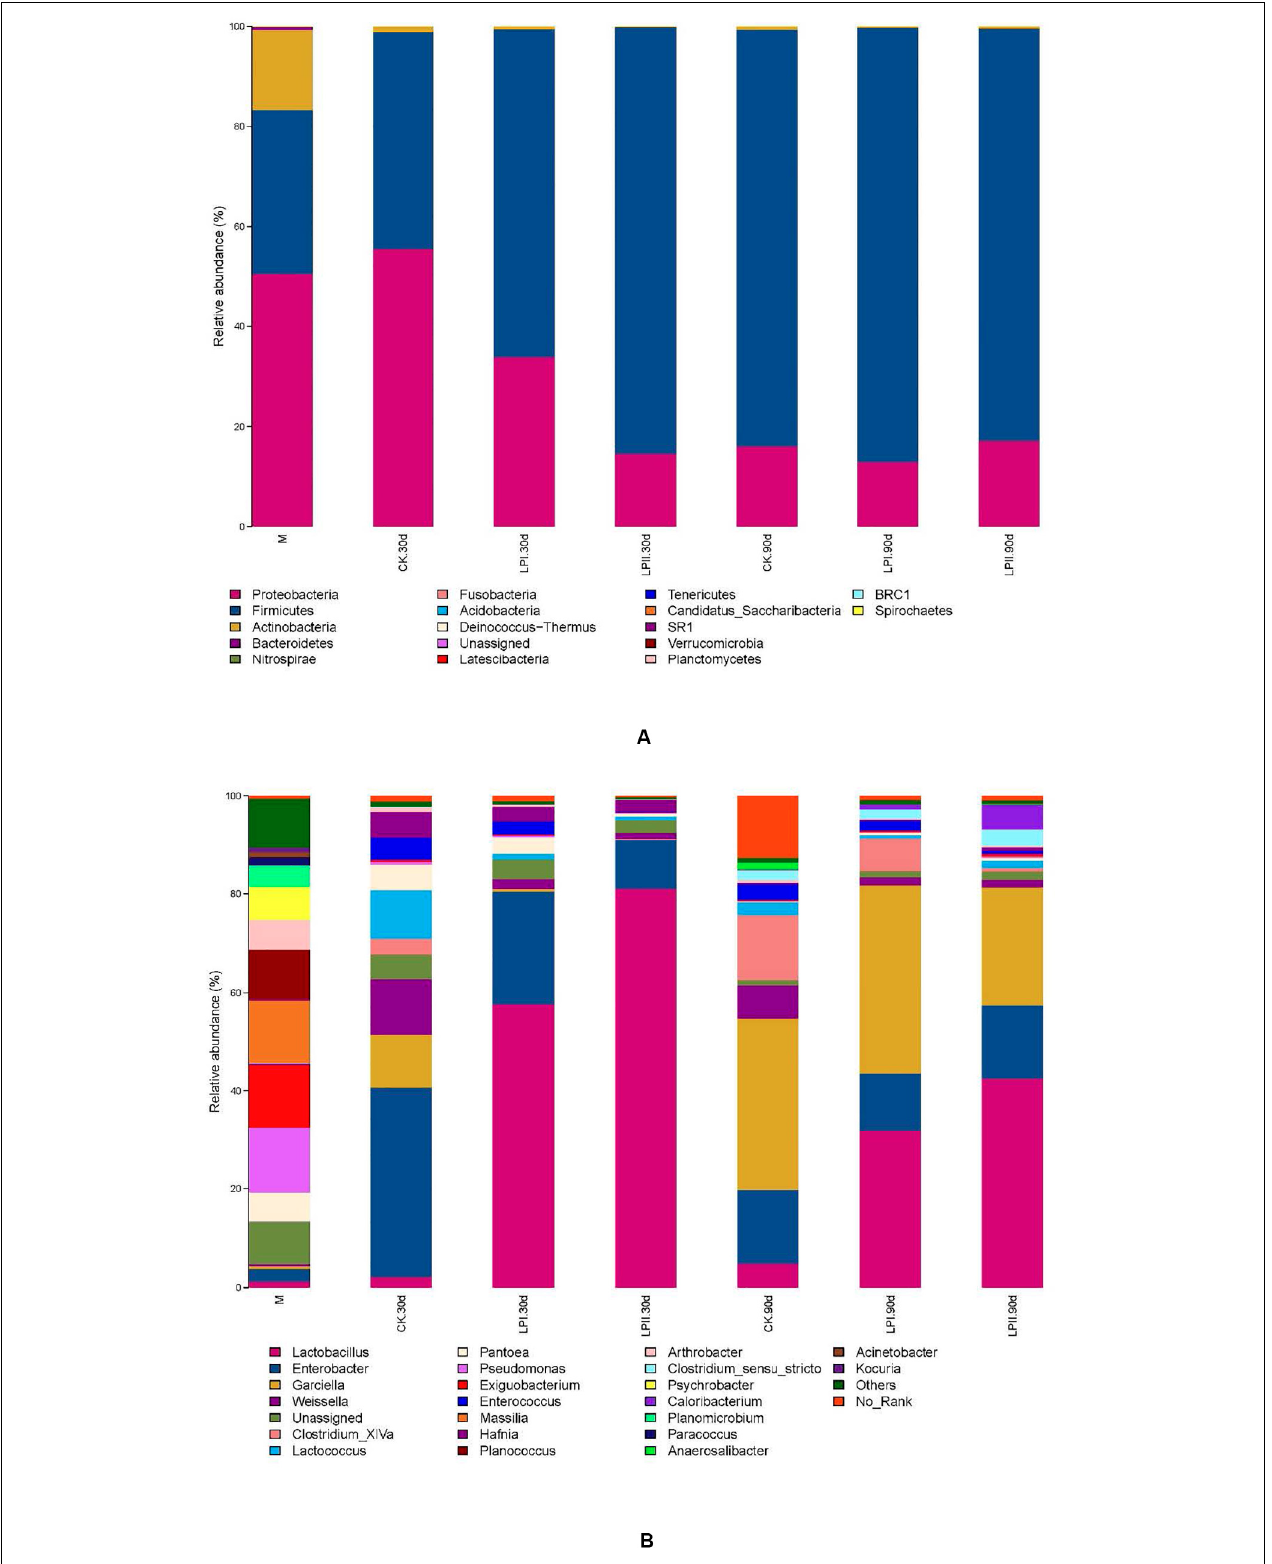
FIGURE 3 | Bacterial community and relative abundances by phylum (A) and genus (B) for alfalfa silage. M, alfalfa material before ensiling; CK, control; LPI, inoculated with L. plantarum YX; LPII, inoculated with L. plantarum A345. The numbers following CK, LPI, and LPII stand for ensiled days of silage.